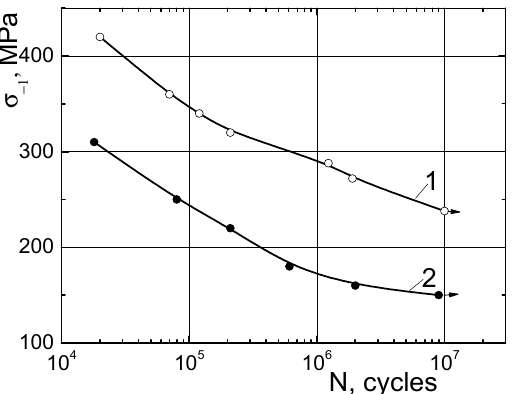
Figure 19. Endurance curves of the combined compounds of the steel 20H3NMFA with the steel 25H2NMFA in air (1) and hydrogen at a pressure of 10 MPa (2).